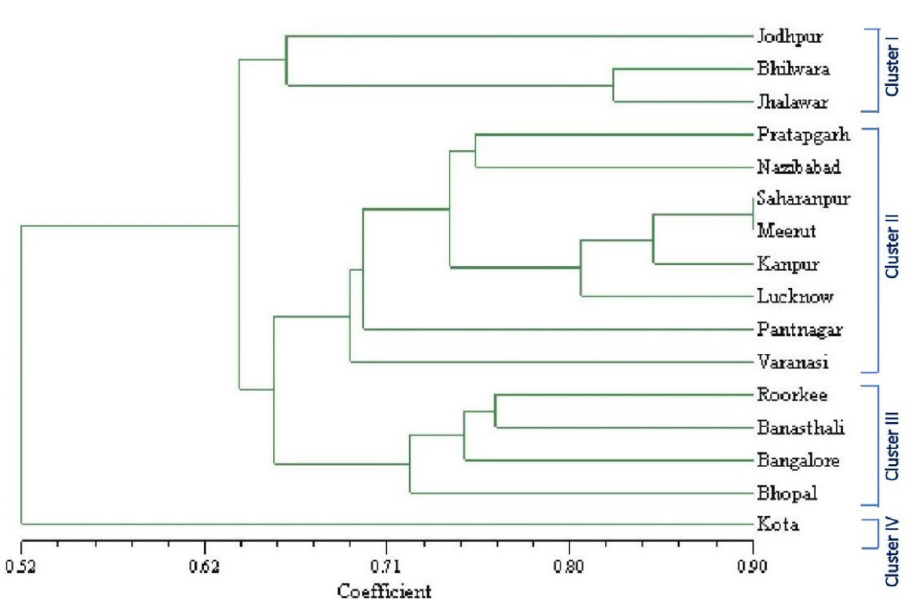
Figure 2. UPGMA dendrogram of 16 accessions of S. cumini based on 98 ISSR markers. Cluster I: Jodhpur, Bhilwara, and Jhalawar; Cluster II: Pratapgarh, Nazibabad, Saharanpur, Meerut, Kanpur, Lucknow, Pantnagar, and Varanasi; Cluster III: Roorkee, Banasthali, Bangalore, and Bhopal; Cluster IV: Kota.